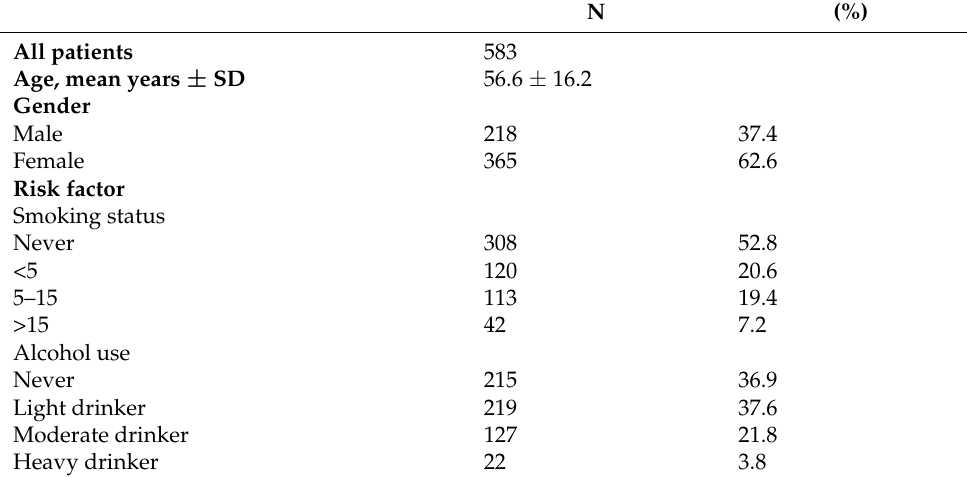
Table 1. The demographic characteristic of